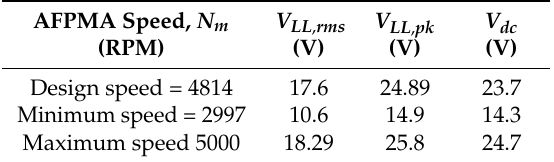
Table 4. AFPMA and rectifier output voltages at no load vs. speed at α = 0 o